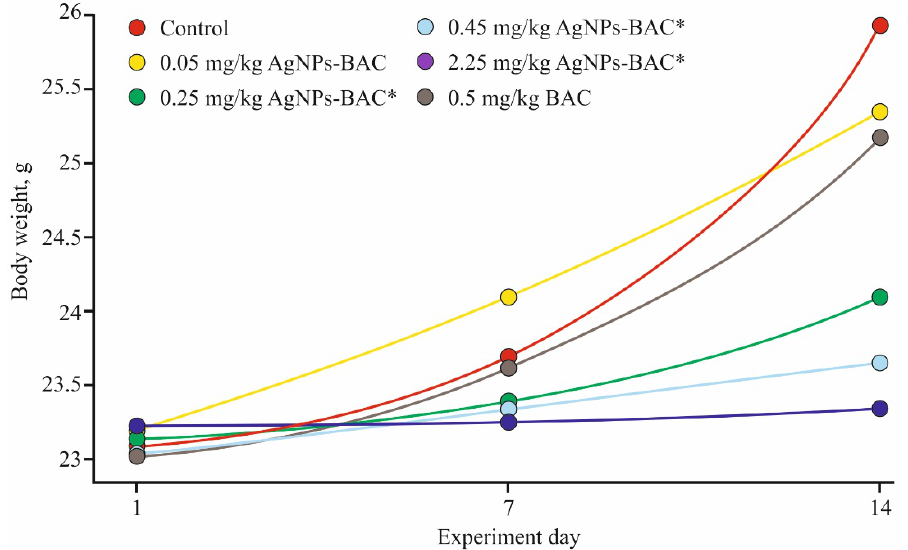
Figure 4. Weight gain dynamics in the subacute experiment. * p < 0.01.